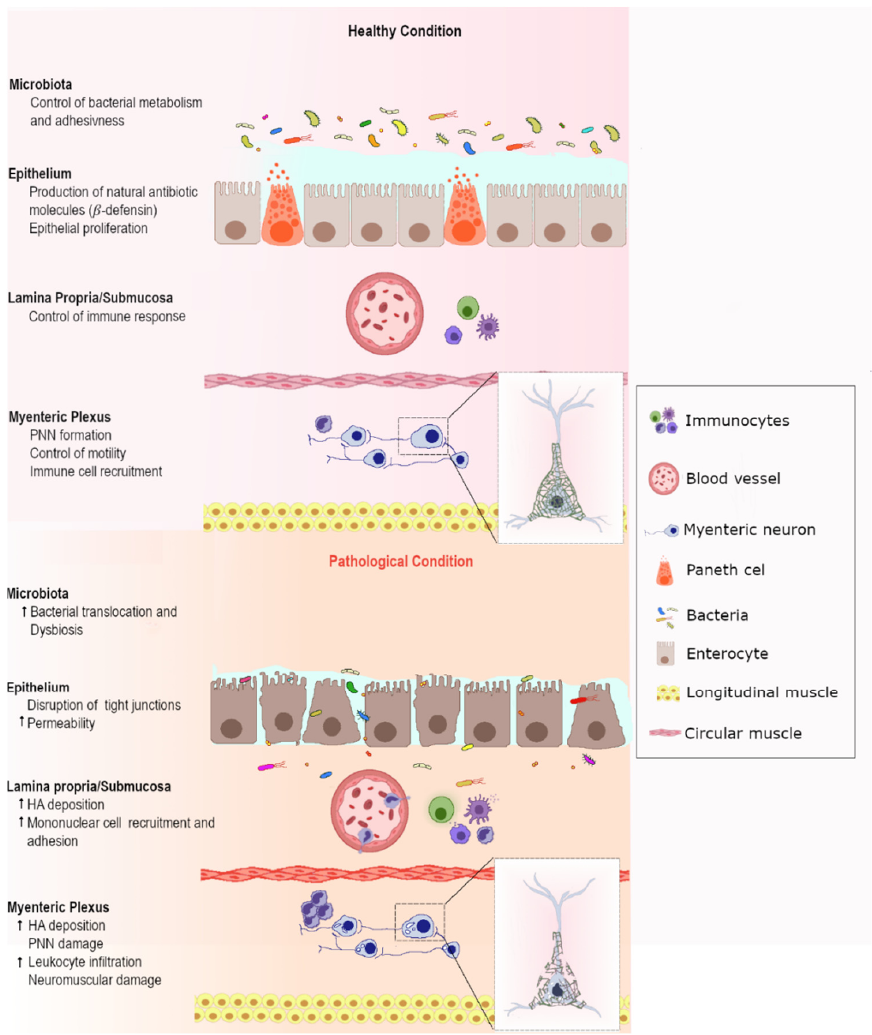
Figure 2. Schematic representation of HA-mediated effects on the gut microbiota and in the neuroimmune compartment in healthy and disease conditions. Abbreviations: HA: hyaluronan; PNN: perineuronal net.